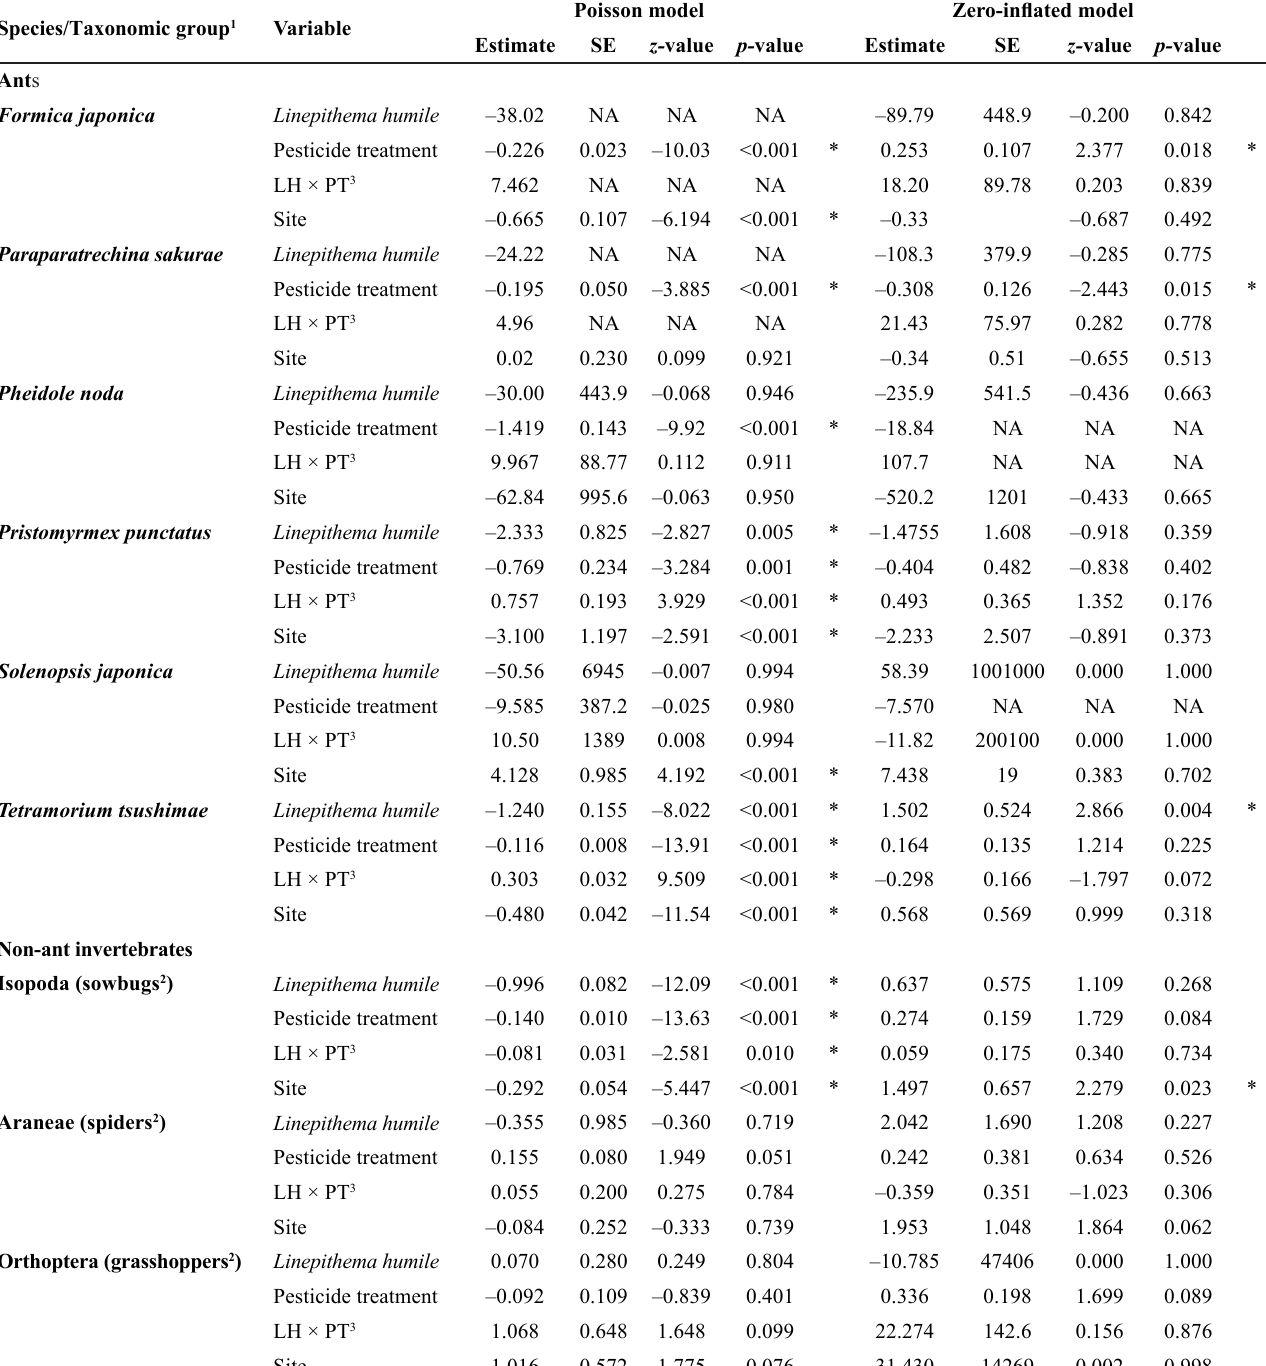
Table 3. Results of zero-inflated Poisson regression models examining the effects of Linepithema humile , pesticide treatment, their interaction, and site on the number of individuals of each ant species or non-ant invertebrate taxonomic group per